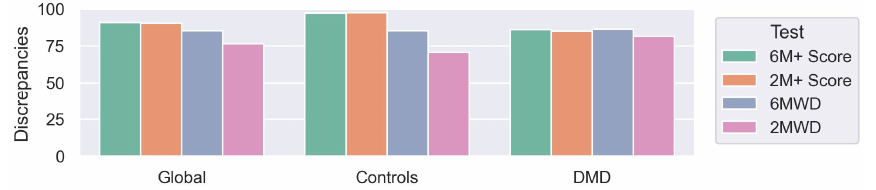
Figure 7. Discrepancies of 6 and 2 min scores (6M+ and 2M+, respectively), 6MWT, and 2MWT in comparison with NSAA score, computed as depicted in Equation (1).